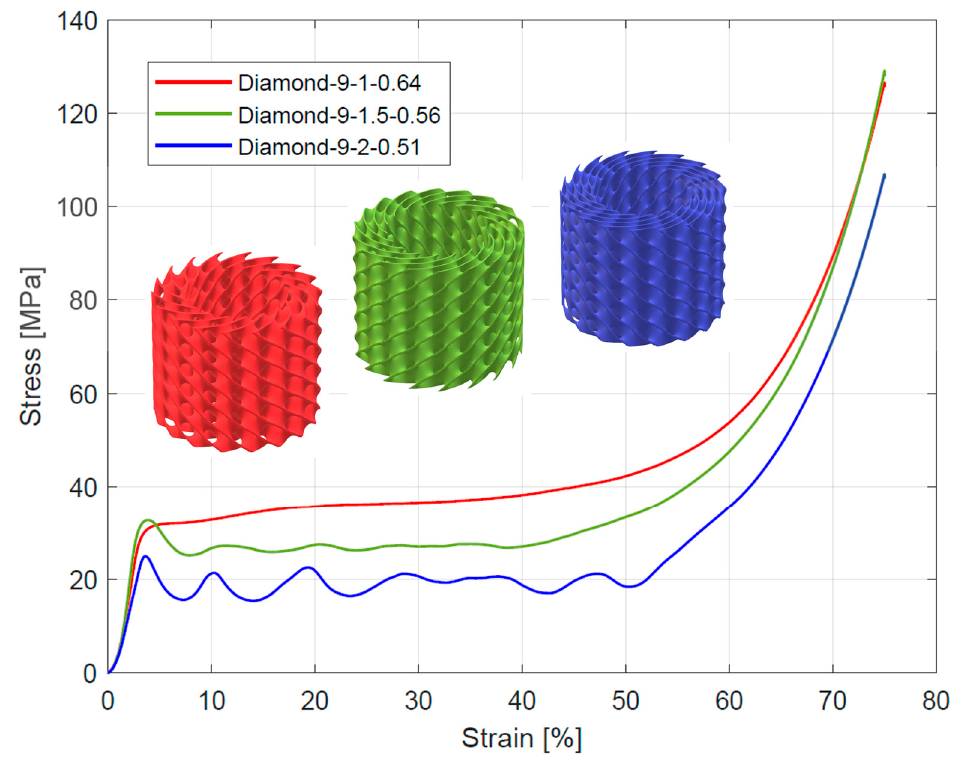
Figure 7. Stress–strain curves from compressive testing of Diamond TPMS cylindrical structures with 9 unit cells in a circumferential direction.